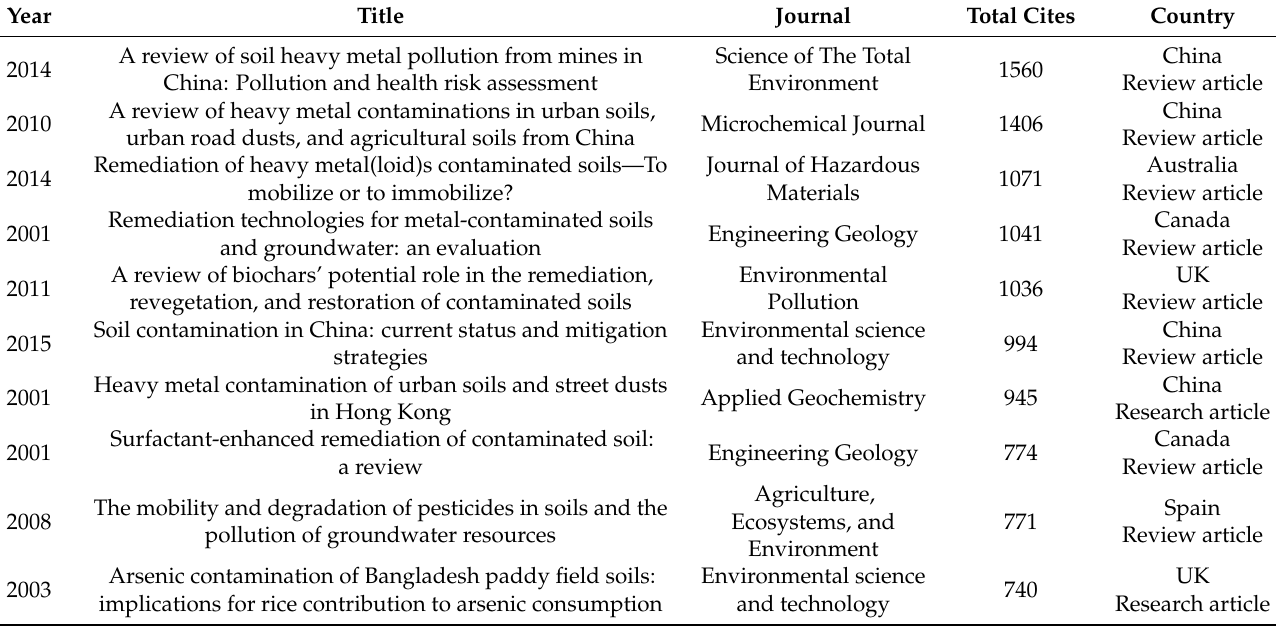
Table 4. Top 10 highly cited studies in the